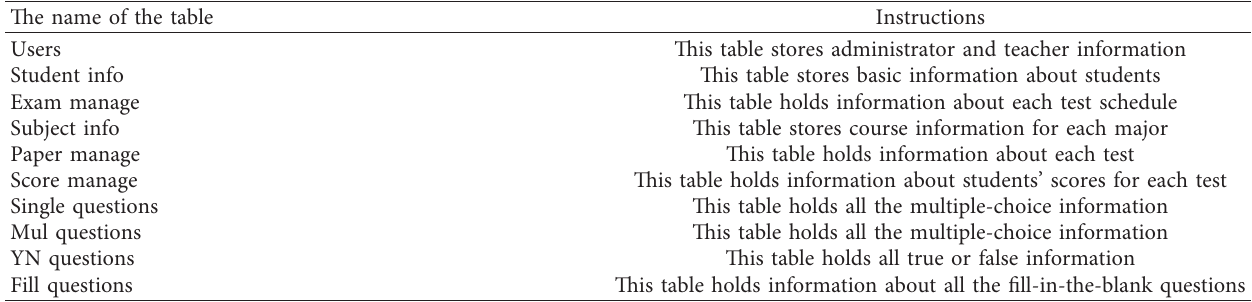
Figure 3: Administrator module Table 1: Overall design table of database physical structure.